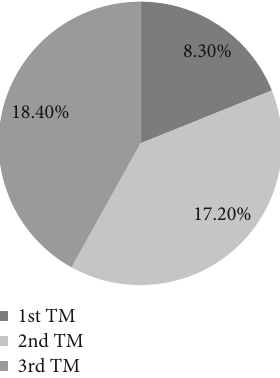
Figure 2: Prevalence of pregnancy related anxiety in trimester among women attending ANC at Debre Markos town public health institutions, Northwest Ethiopia,